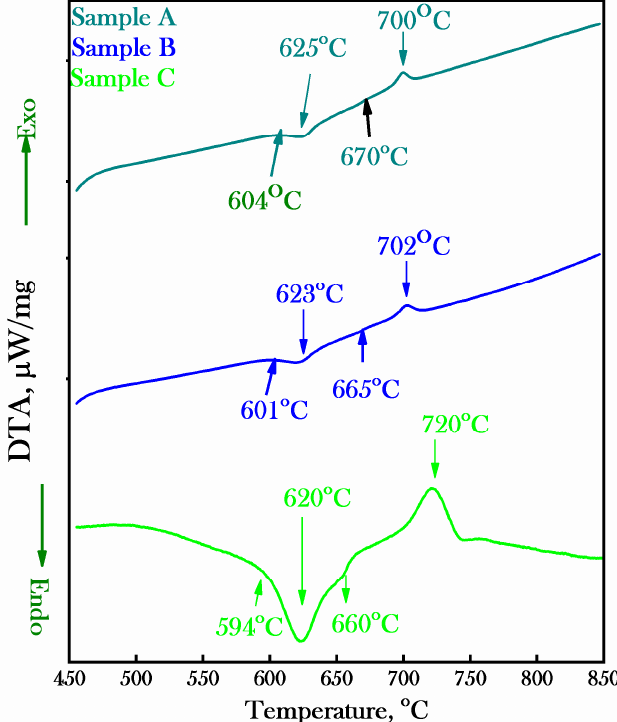
Figure 2. Differential thermal analysis versus temperature of Sample A, Sample B and Sample °C alloys after the complete heat treatment showing the onset, peak and phase transformation temper- atures.